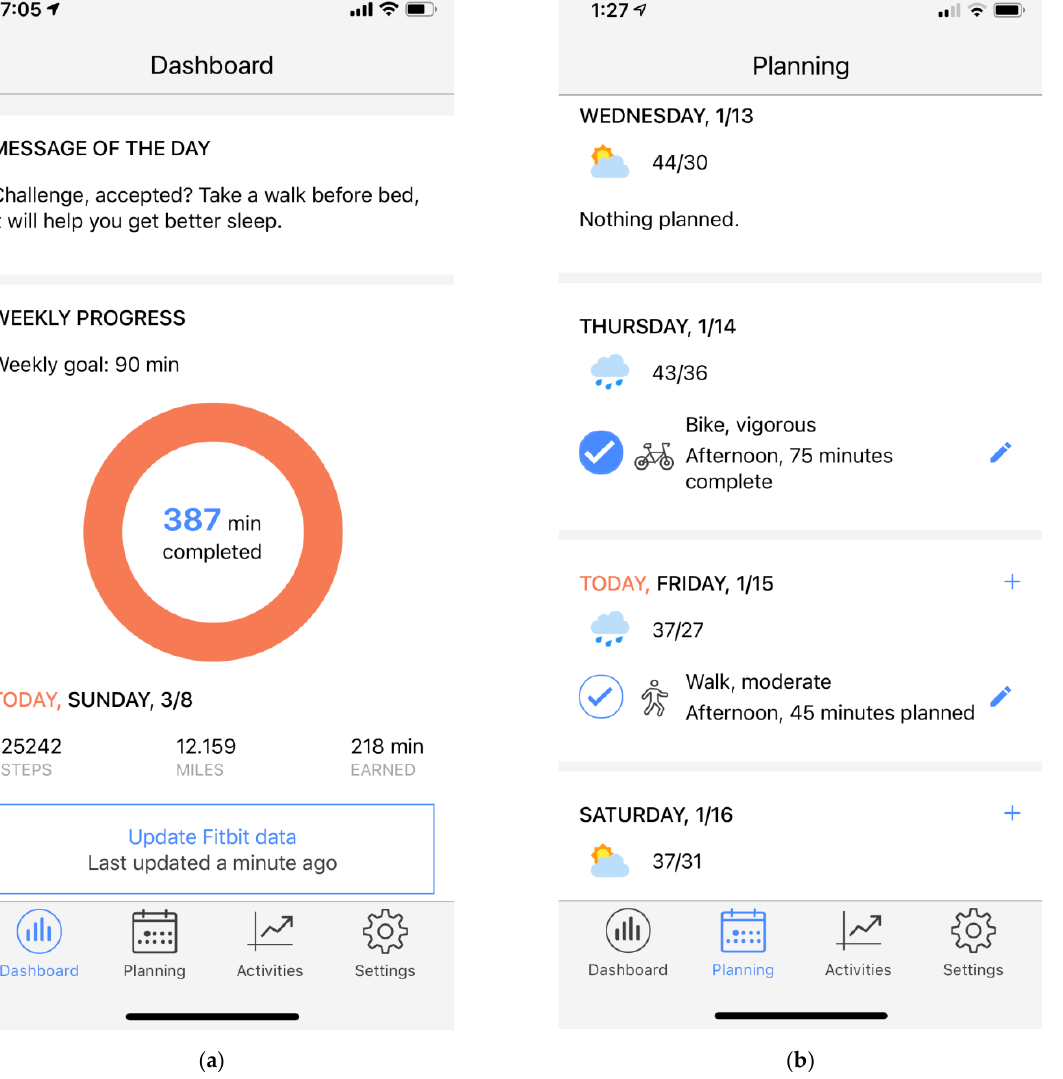
Figure 1 Screenshots of the HeartSteps application: ( a ) HeartSteps dashboard; ( b ) Main planning screen.